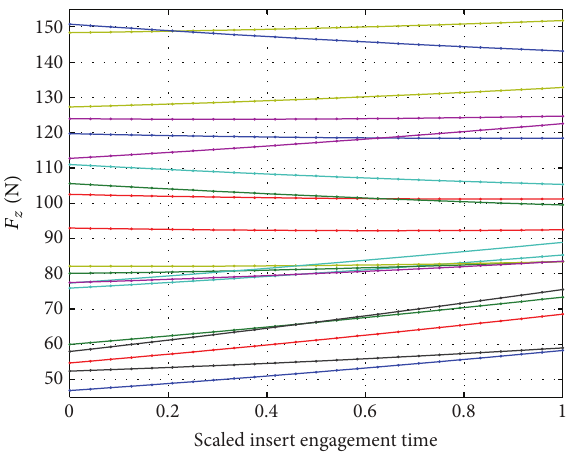
Figure 5: Functional data made out of recorded data for cutting force component in 𝑍 direction during end milling experiments.